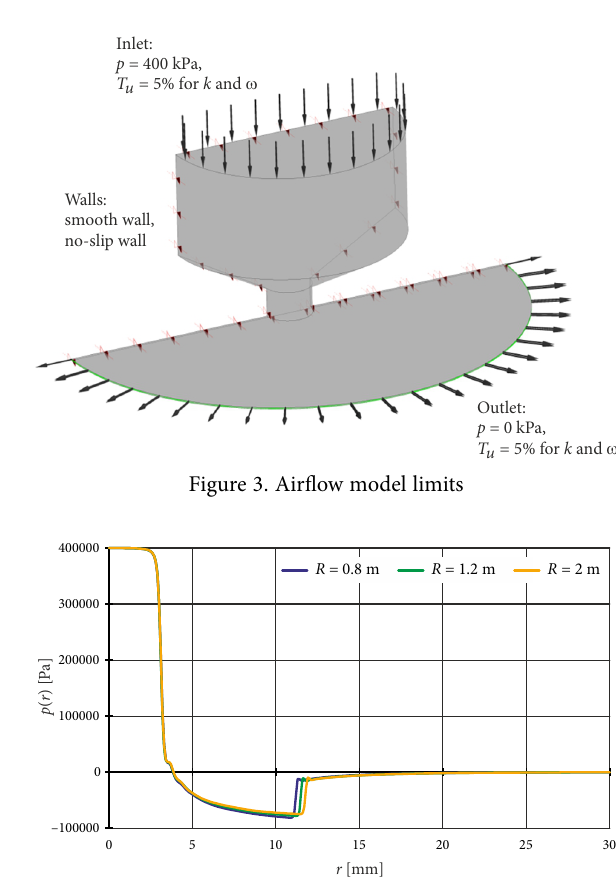
Figure 4. Plots of pressure p distribution in the interval between the flat end of the BGD and the spherical surface r for different values of radius R of this surface